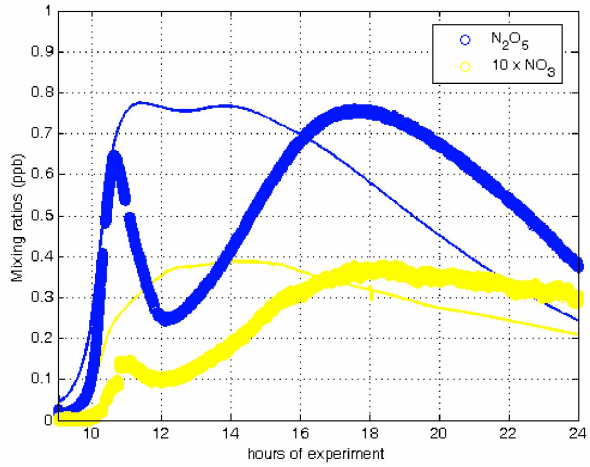
Fig. 7. Measurement/model agreement of NO 3 and N 2 O 5 after the second limonene injection. No reasonable permutations of model parameters achieved better agreement with the NO 3 “dip”.